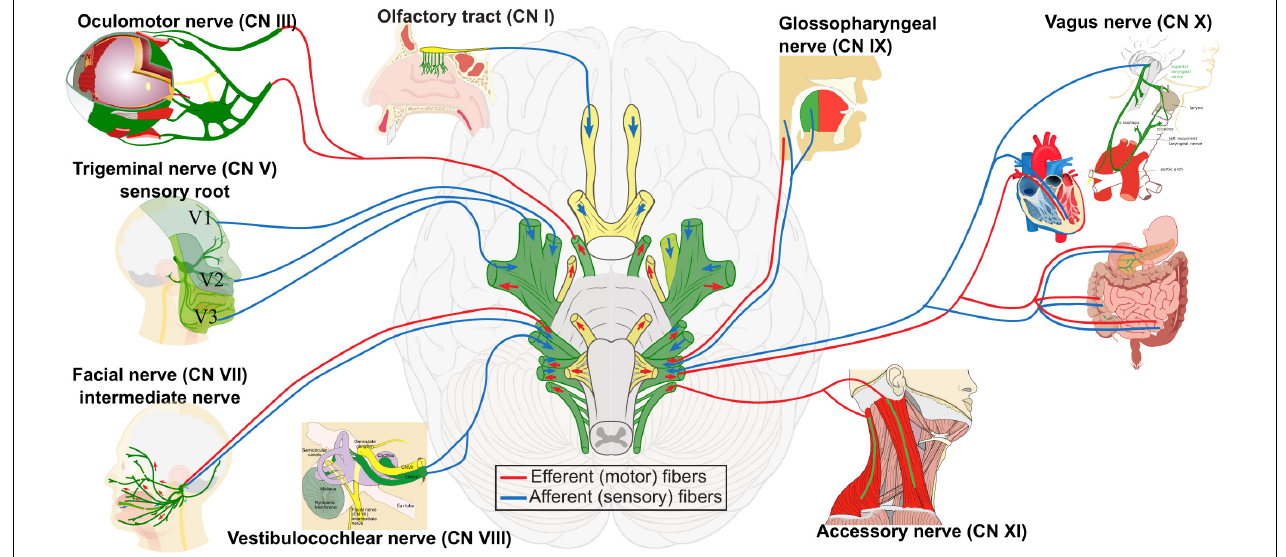
FIGURE 2 | Contribution of neural crest cells to the formation of cranial nerves I, III, V, VII, VIII, IX, X, and XI. These selected cranial nerves are formed by the contribution of cranial placodes and neural crest cells, indicated in green. Neural crest-derived Schwann cells produce peripheral myelination of cranial nerves III–XII. The sensory nerves are the olfactory (I), the optic (II), and the vestibulocochlear (VIII). The motor nerves are the oculomotor (III), the trochlear (IV), the abducens (VI), and the accessory (XI). The remaining are mixed